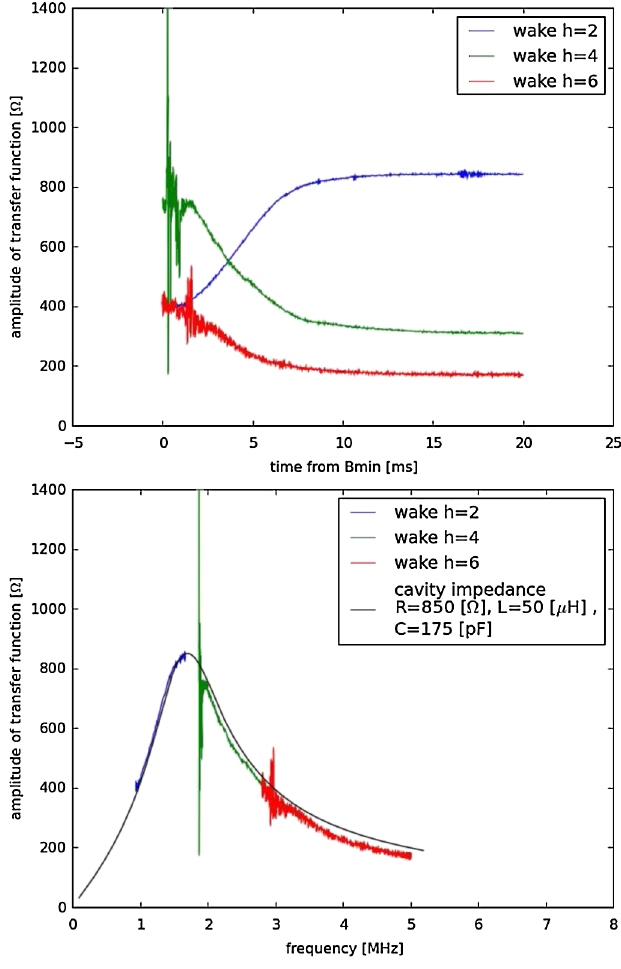
FIG. 8. Translation to impedance. Z ð ! Þ ¼ V ð ! Þ =I ð ! Þ —(top) as function of time and (bottom) frequency